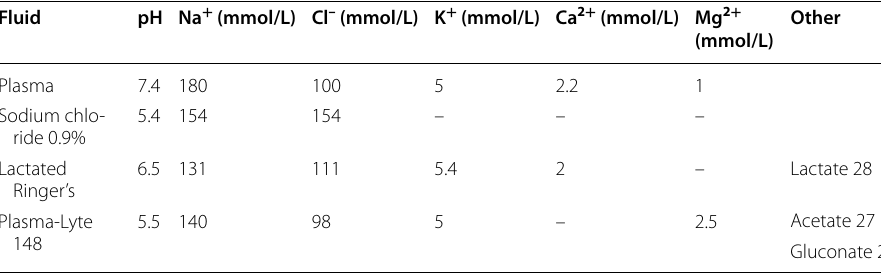
Dash denotes absent from the fluid